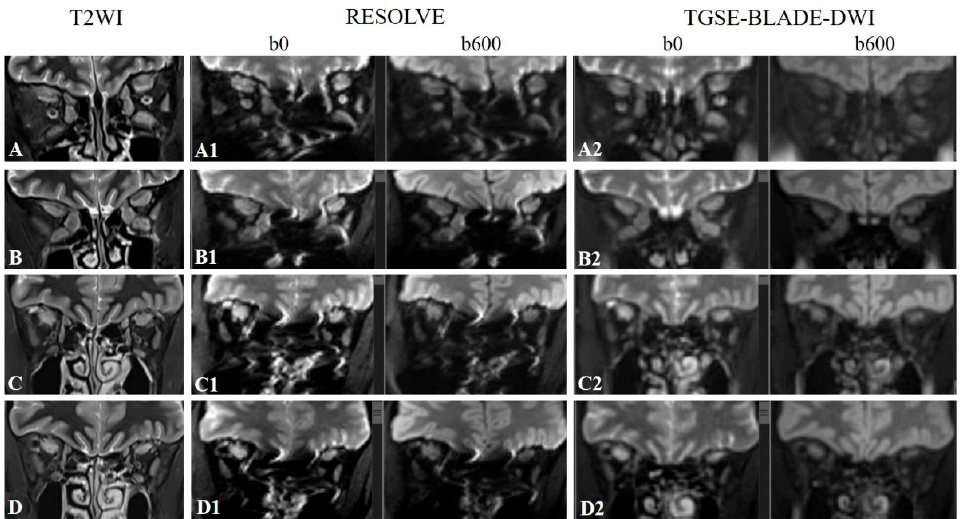
Figure 1. Representative coronal T2-weighted imaging (T2WI) images ( A – D ), coronal RESOLVE DWI b0 and b600 images ( A1 – D1 ), and coronal TGSE-BLADE-DWI b0 and b600 images ( A2 – D2 ) of a 54-year-old female patient with CAS = 4 ( A , A1 , A2 , and B , B1 , B2 ) and a 50-year-old male patient with CAS = 3 ( C , C1 , C2 and D , D1 , D2 ). For slice 1 ( A , A1 and A2 ), the subjective scores for the right superior rectus, right inferior rectus, right medial rectus, right lateral rectus, left superior rectus, left inferior rectus, left medial rectus, and left lateral rectus were 3, 2, 2, 2, 3, 2, 1, and 2 for RESOLVE and 3, 2, 3, 1, 3, 3, 2, and 1 for TGSE-BLADE-DWI, respectively. For slice 2 (B, B1 and B2), the sub- jective scores for the EOMs were 3, 3, 2, 1, 3, 1, 1, and 1 for RESOLVE and 3, 3, 3, 1, 3, 3, 3, and 2 for TGSE-BLADE-DWI, respectively. For slice 3 (C, C1 and C2), the subjective scores for the EOMs were 3, 1, 1, 3, 3, 1, 2, and 3 for RESOLVE and 3, 2, 2, 1, 3, 3, 3, and 3 for TGSE-BLADE-DWI, respectively. For slice 4 (D, D1 and D2), the subjective scores for the EOMs were 3, 1, 1, 2, 3, 1, 1, and 3 for RE- SOLVE and 3, 1, 1, 1, 3, 3, 3, and 2 for TGSE-BLADE-DWI, respectively. 2.4. Objective Evaluations Two pairs of region-of-interest (ROI) for each patient were delineated for quantitative assessment. First, among the 280 EOMs with acceptable DWI image quality scores ( ≥ 2), a circular ROI was placed on both ADC maps obtained from RESOLVE and TGSE-BLADE- DWI. The mean ADC values generated from the two DWIs for each EOM were recorded for comparison. Second, for each patient, one ROI was delineated on the maximum cross-section in all eight EOMs on the coronal T2WI-short Tau inversion recovery (STIR) image, and the ROI area was recorded as Size max. Then, ROI was placed on the ADC maps of the cross- section of the same muscle, and the ROI was manually adjusted to avoid pixels with image distortions, artifacts, and rectus margins. The corresponding mean ADC values on RE- SOLVE and TGSE-BLADE-DWI images were recorded as cADC. Finally, the Size max and cADC of active and inactive TAO were compared, and the correlations between cADC and Size max , and cADC and CAS grading were also evaluated. 2.5. Statistical Analysis Continuous variables were presented as the means ± standard deviation (SD). If the ADCs of the 280 EOMs between RESOLVE and TGSE-BLADE-DWI, Size max , and cADCs between the active and inactive phases conformed to a normal distribution, the paired t- test was used. Otherwise, the Wilcoxon signed-rank test was used. Correlations of cADC and Size max and CAS were evaluated by the Pearson correlation. Receiver operating char- acteristics (ROC) curves were used to evaluate the diagnostic performance of the ADC values of each EOM for differentiating active and inactive TAO, and the method presented by Delong et al. [26] was used to compare the area under curves (AUCs) of the two DWIs